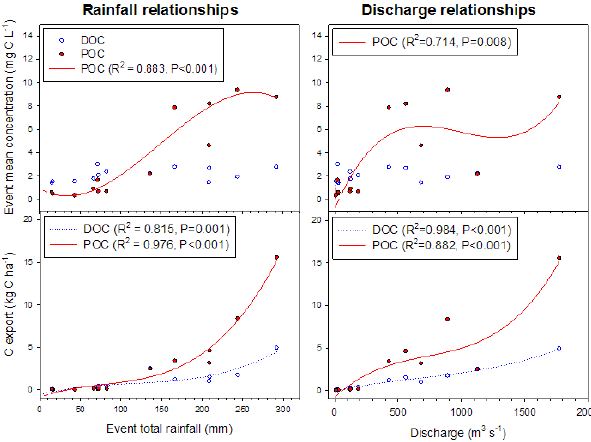
Figure 2. Relationships between measures of storm magnitude (event total rainfall or discharge) and the discharge-weighted event mean concentrations or the export of DOC and POC in the forest stream during 13 storm events. Best-fit regressions are indicated only if P